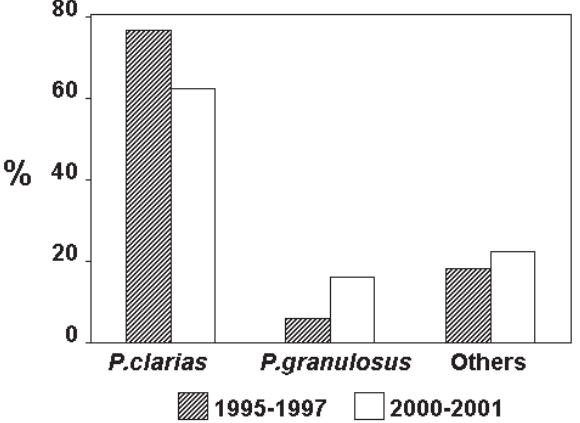
Fig. 2. Species composition of fishes sampled in the Yacyreta elevators. Data from 1995-1997 adapted from Oldani et al., (2002) and from 2000-2001 adapted from Roncati et al. (2000;